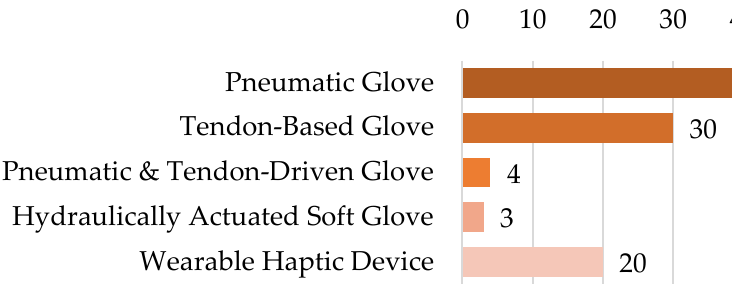
Figure 15. Distribution of the soft gloves among